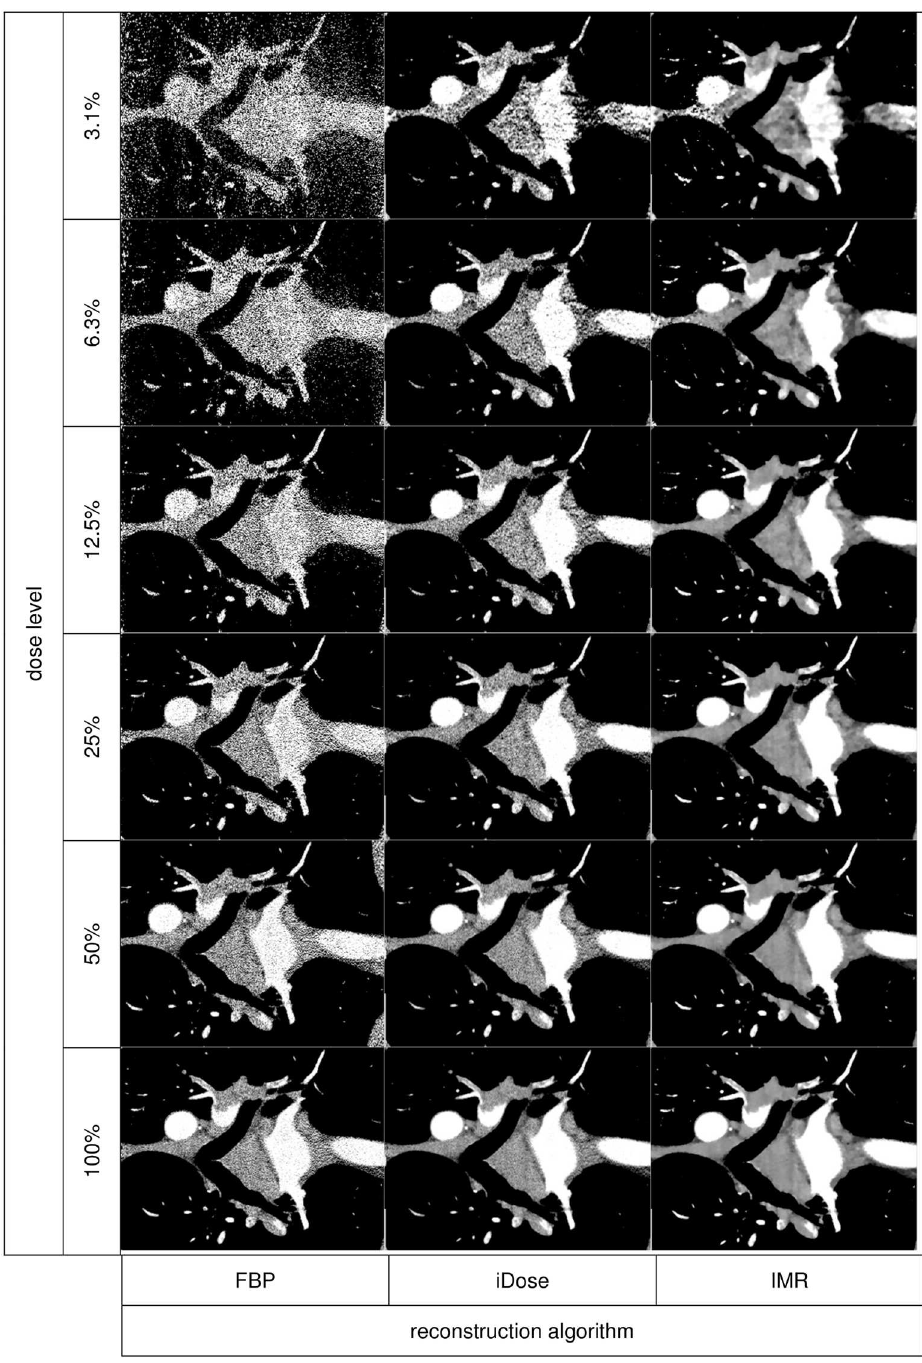
Fig 4. Comparison of FBP, iDose and IMR at dose levels of 3.1–100%. Enlargedview of the coronal tomographic slices of the chest fromFig 3, indicatedby the red dashedrectangle.Comparison of FBP (top), iDose (middle)and IMR (bottom)at differentdose levels (fromleft to right:100%–50%–25%–12.5%–6.3%– 3.1%).Emboli are locatedin the rightpulmonary artery, the left upper and lower lobararteryand in several segmental arteriesof the left lung. Note the good detectability even at ultra-lowdose levels with IMR.With iDose emboliare also detectablebut imagequalityis inferiorto IMR.With FBP, emboliare not certainly detectable at lower dose levels. FBP = filteredback projection , iDose= iterative dose reduction , IMR = iterative modelreconstruction .